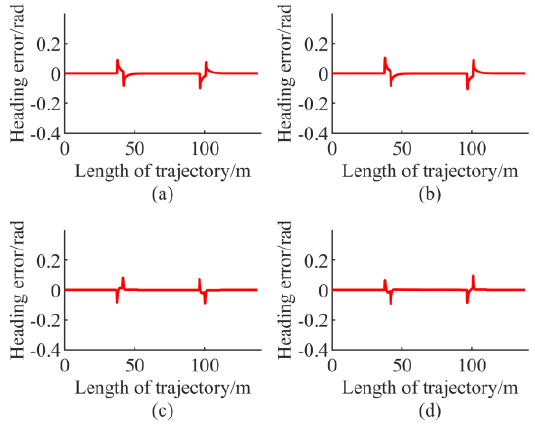
Figure 5. The heading error when velocity is 2 m / s. ( a ) LMPC. ( b ) LEMPC. ( c ) NMPC. ( d ) NEMPC.